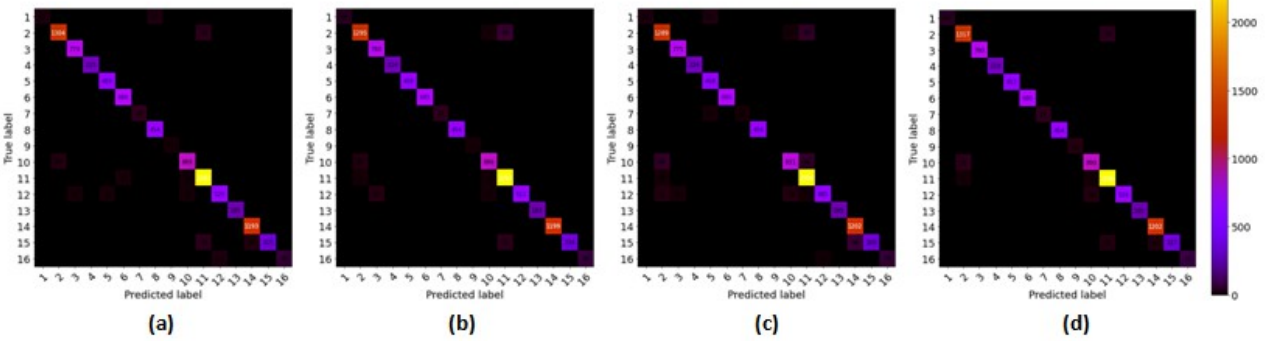
Figure 13. The confusion matrix of IP dataset: ( a ) R-HybridSN; ( b ) HybridSN; (c) SSRN; ( d ) HybridGBN-SR.